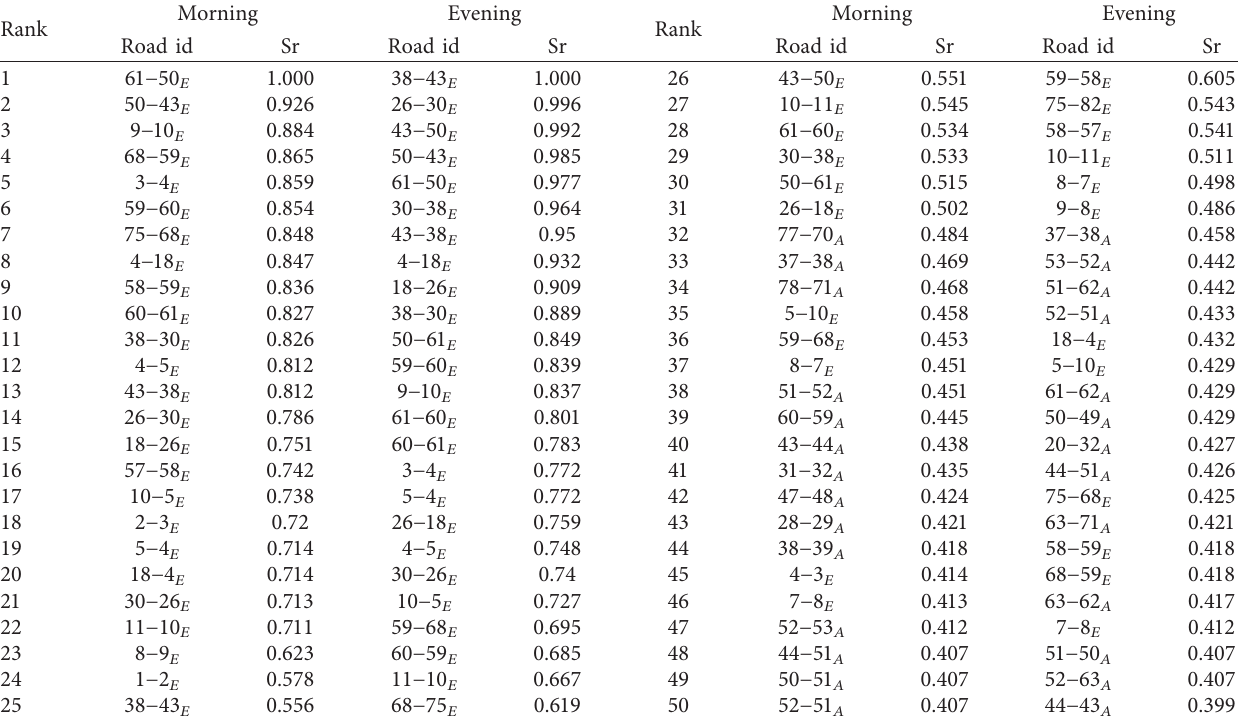
Figure 10: Identification results of key roadway sections in peak hours on Saturday. (a) 9:00–11:00. (b) Table 3: Top 50 key roadway sections in peak hours on Monday.